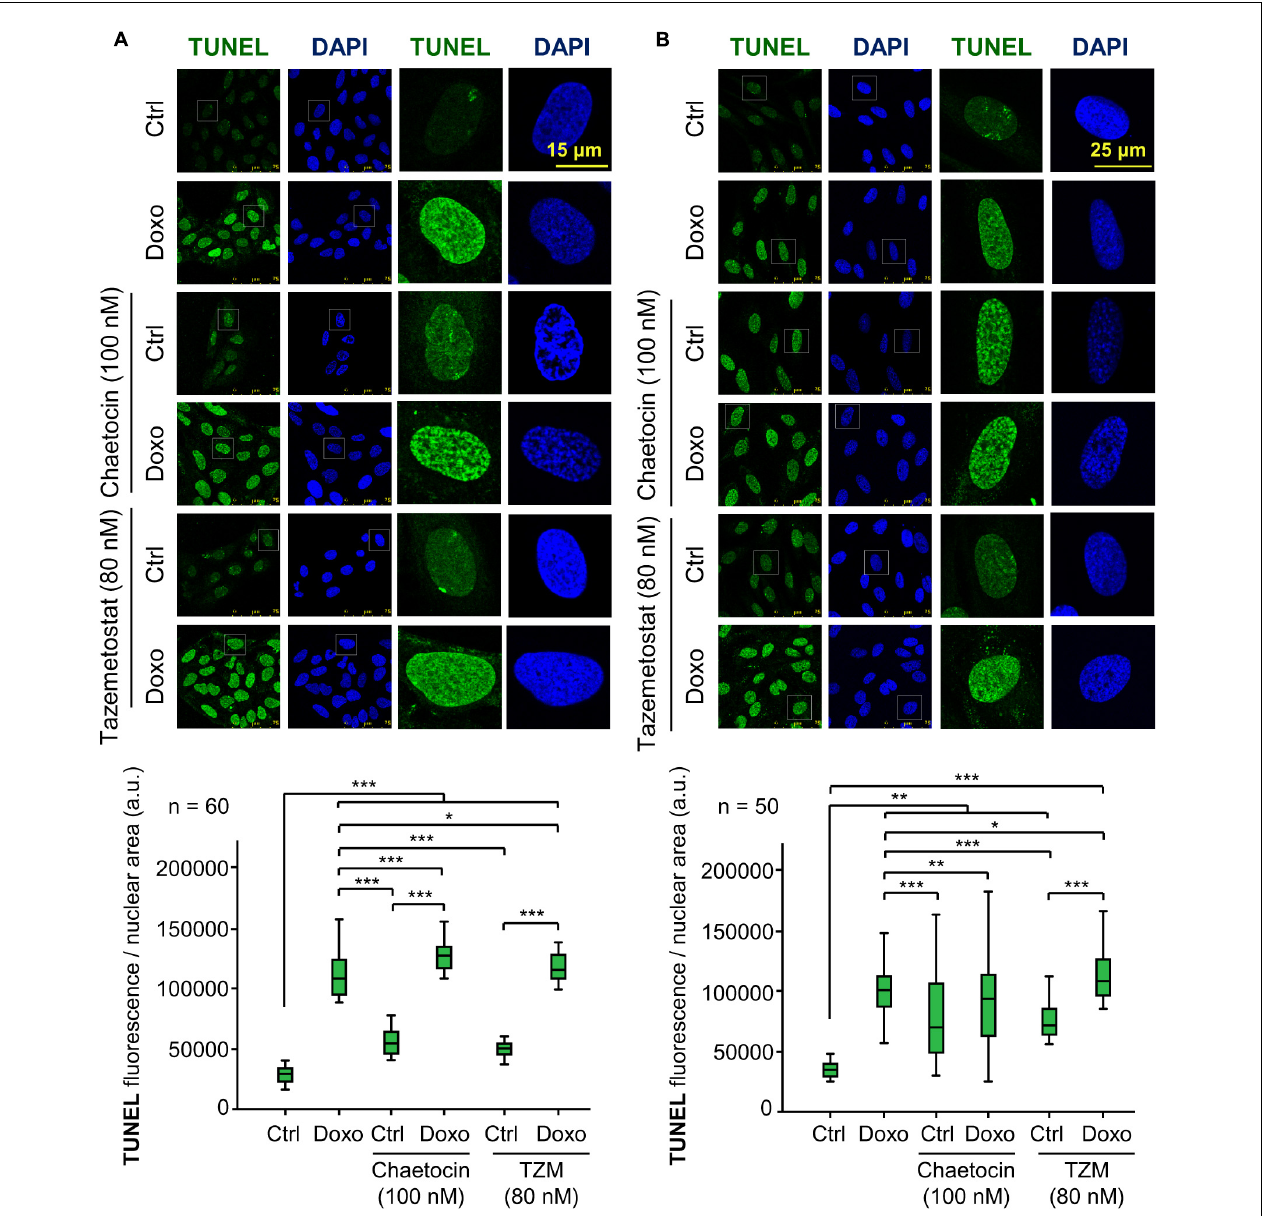
FIGURE 9 | Effect of chaetocin and tazemetostat on the induction of DNA damage detected in TUNEL assays in U2OS (A) and SK-LMS-1 (B) sarcoma cells deprived of serum. DNA damage was detected by labeling free DNA ends. * p < 0.05, ** p < 0.01, and *** p < 0.001. Ctrl, control without